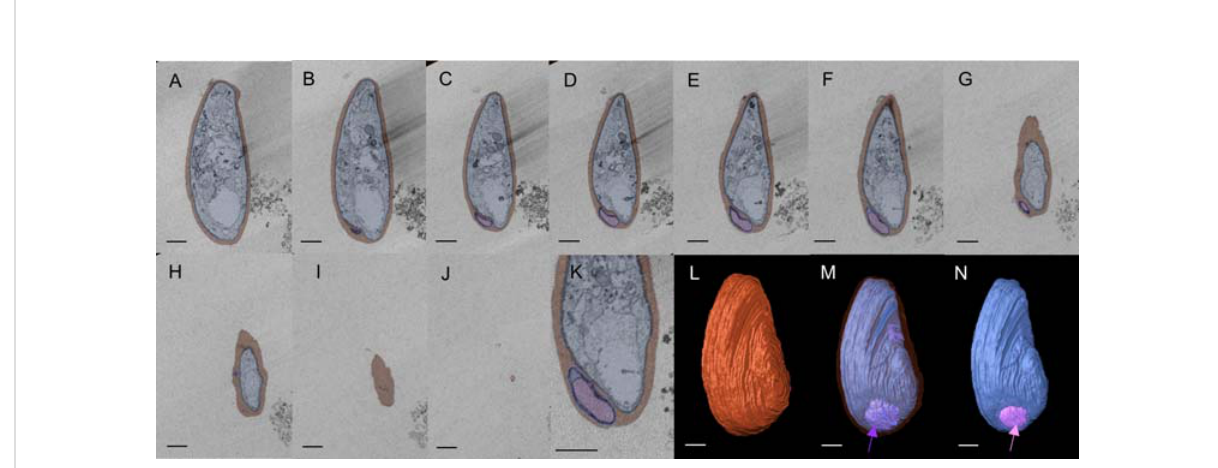
FIGURE 2 Three-dimensional reconstruction of SBF-SEM imaging showing multi-layered pouch Sections of SBF-SEM images were integrated into a single 3D image (total 38 images). (A – J) Series of image sections used to construct the 3D image. Only representative sections are shown. Erythrocytes are shown in red, and exo-membranes are colored purple and pink. (K) Enlarged image of (E) . (I) Erythrocyte membrane is shown in brown. (M) Pouches (purple) located between PVM (blue) and erythrocyte membrane (translucent layer). (N) Pink segments highlight inner membranous objects within the purple layer as membrane whorl. Scale bar = 1 µm (a-j, l-n), 500nm (K)